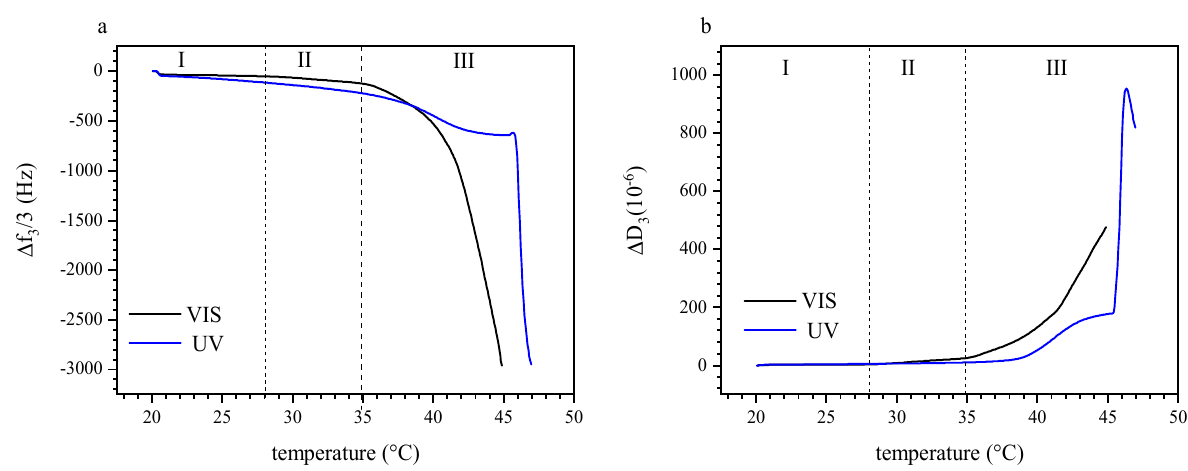
Figure 6. ( a ) Variation of normalized ∆ f 3 /3 as a function of temperature upon irradiation of P (TEGA-co-SPA) copolymers at the silica–water interface, the copolymer was introduced at T = 20 ◦ C, ( b ) variation of ∆ D 3 as function of temperature of the same solution. Blue curves: Upon UV illumination, Black curves, upon illumination with visible light. The labels (I–III) mark the three regimes of adsorption and film response discussed in the text.